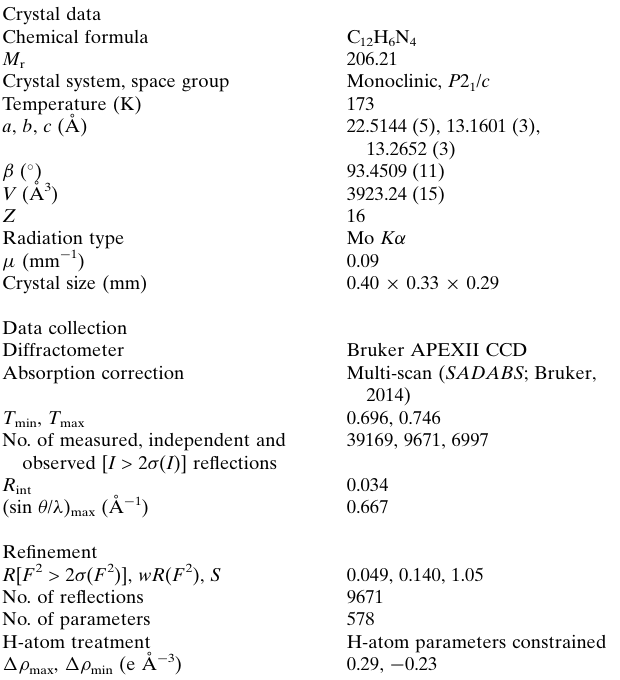
Table 2 Experimental , (cid:5) z + 1 ; (ii) (cid:5) x + 2, y (cid:5) 1 , (cid:5) z + 1 ; (iii) x , 2 2 2 2